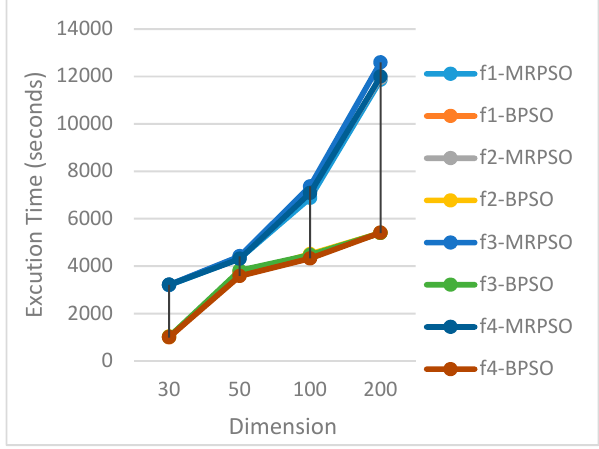
Figure 4. Running time and dimensions.